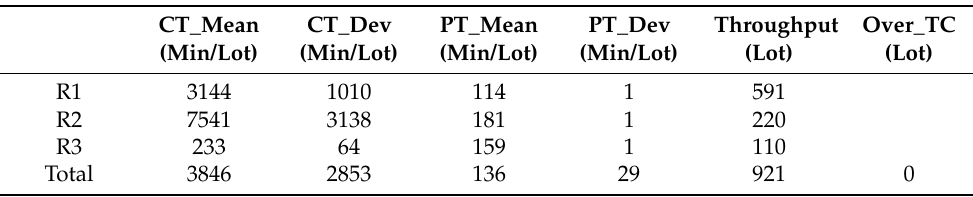
Table 4. Performance of proposed model.